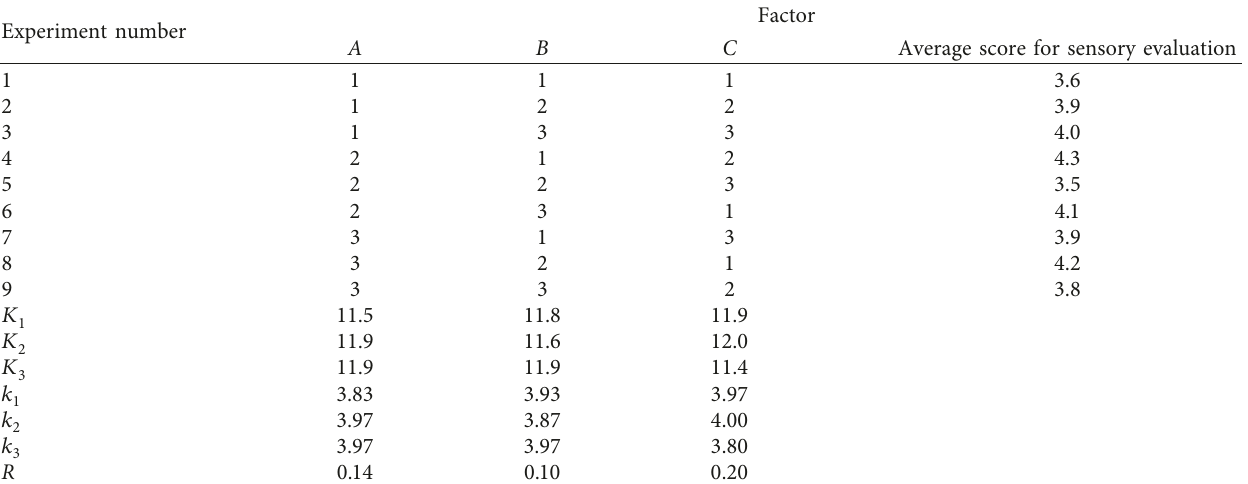
Table 11: Results of orthogonal experiments on the dosage of compound juice ratios in scheme II. Experiment